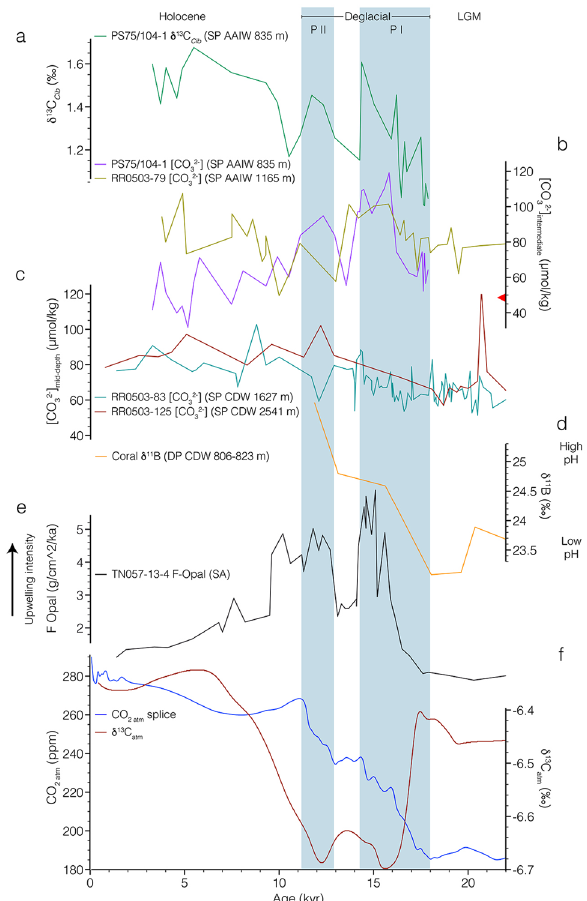
Figure 3. Southern Ocean proxy records in relation to atmospheric records. (a) PS75/104-1 δ 13 C (green). (b) Southwest Pacific intermediate-water [CO 3 2− ] records. PS75/104-1 (purple; this study), RR0503-79 39 (yellow). Red triangle—modern [CO 3 2− ] sat 49.48 µmol/kg at depth of PS75/104-1 58 . (c) Southwest Pacific mid depth [CO 3 2– ] records. RR0503-83 (teal), RR0503-125 39 (dark-red). (d) Drake Passage coral δ 11 B data 34 (orange).